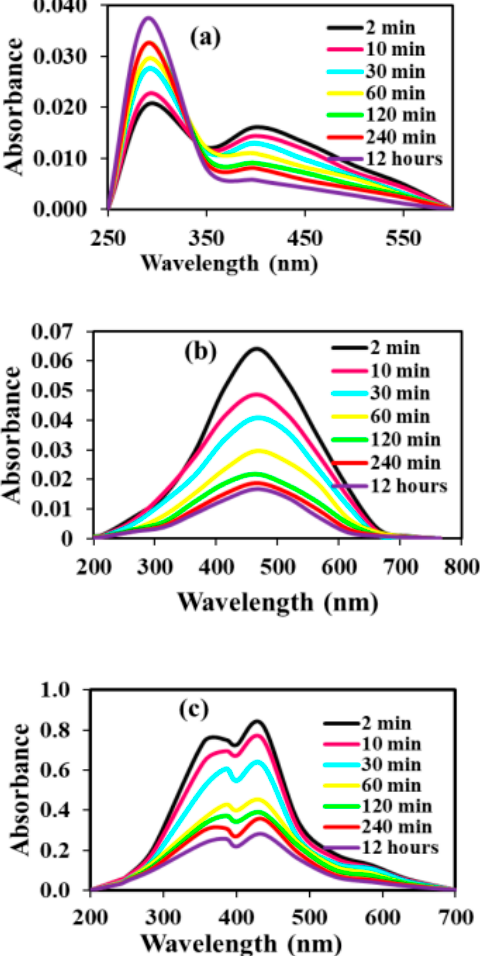
Figure 9. ( a ) Temporal curves for photocatalytic degradation of ( a ) p -nitrophenol, ( b ) pendimethalin and ( c ) Martius yellow (experimental conditions: pH, 3.0; catalyst dose, 0.2g/L and concentration, 0.5 mg/L ( p -nitrophenol and pendimethalin), 0.05 mg/L (Martius yellow)).